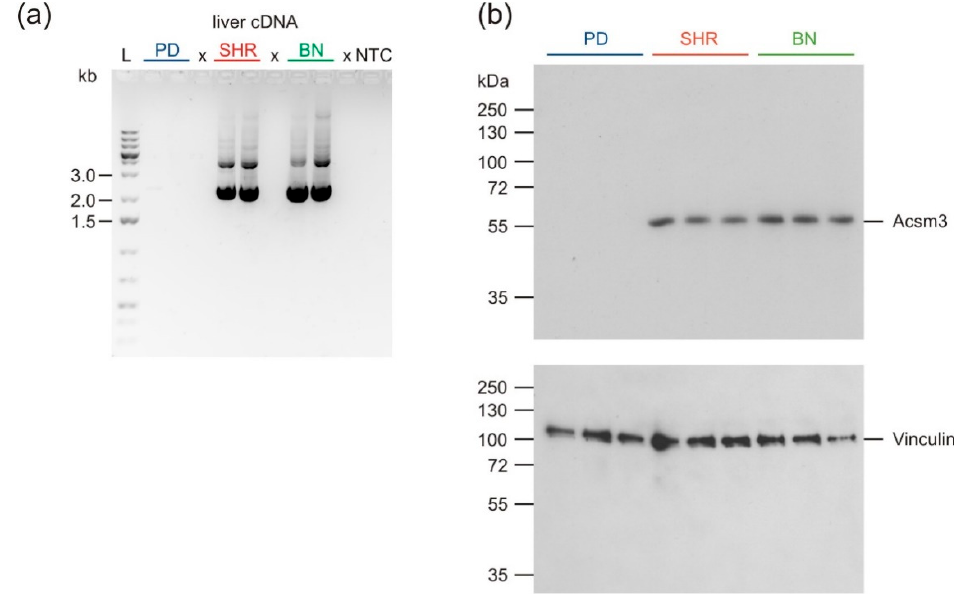
Figure 5. Expression of Acsm3 in the liver of adult male rats-PD (blue), SHR (red), and BN (green); after HFD. ( a ) RT-PCR of Acsm3 , visualized on gel electrophoresis (two representative samples for each strain). Primers flank the complete coding sequence; the expected size of the PCR product is 2296 bp. ( b ) Western blotting of ACSM3 (expected molecular weight of the mature polypeptide 63.2 kDa). Vinculin (expected molecular weight 116.6 kDa) was used as the loading control (three representative samples for each strain).